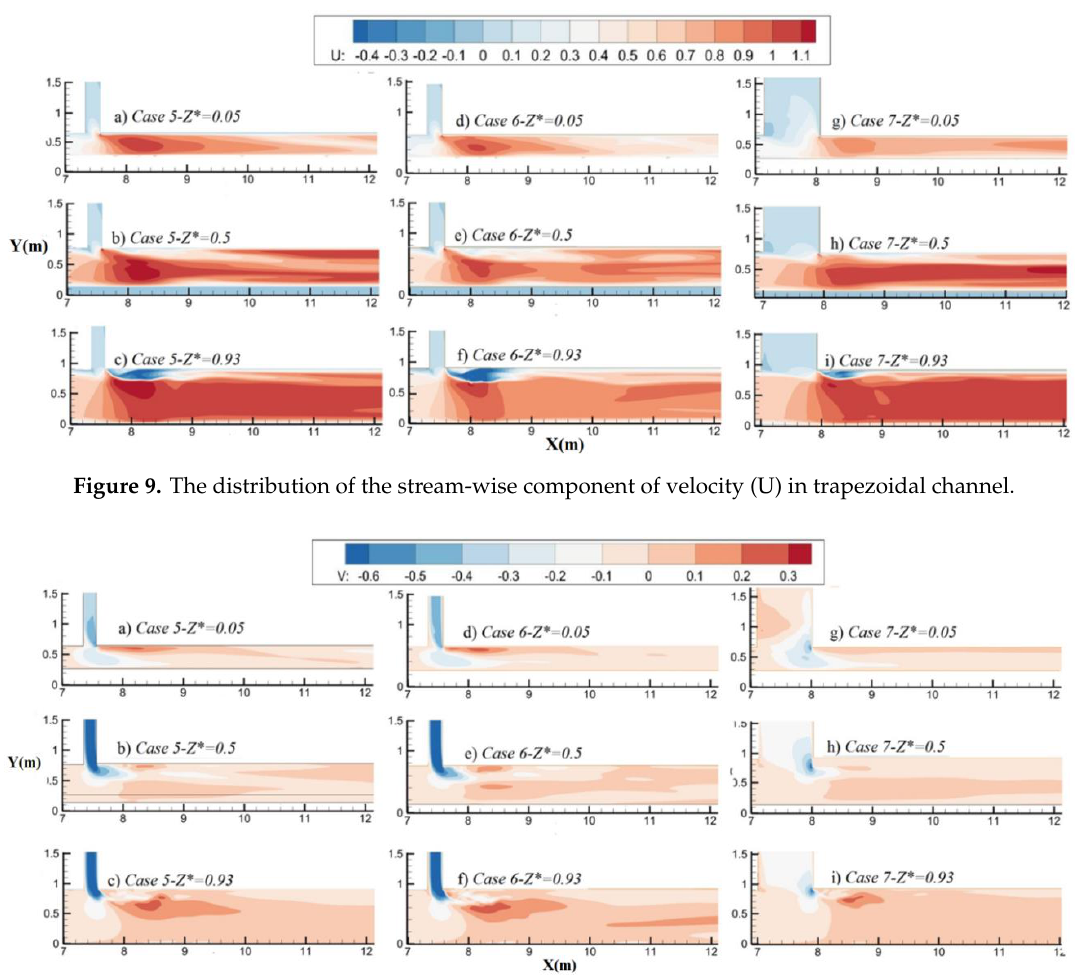
Figure 10. The distribution of the normal component of velocity (V) in trapezoidal channel.